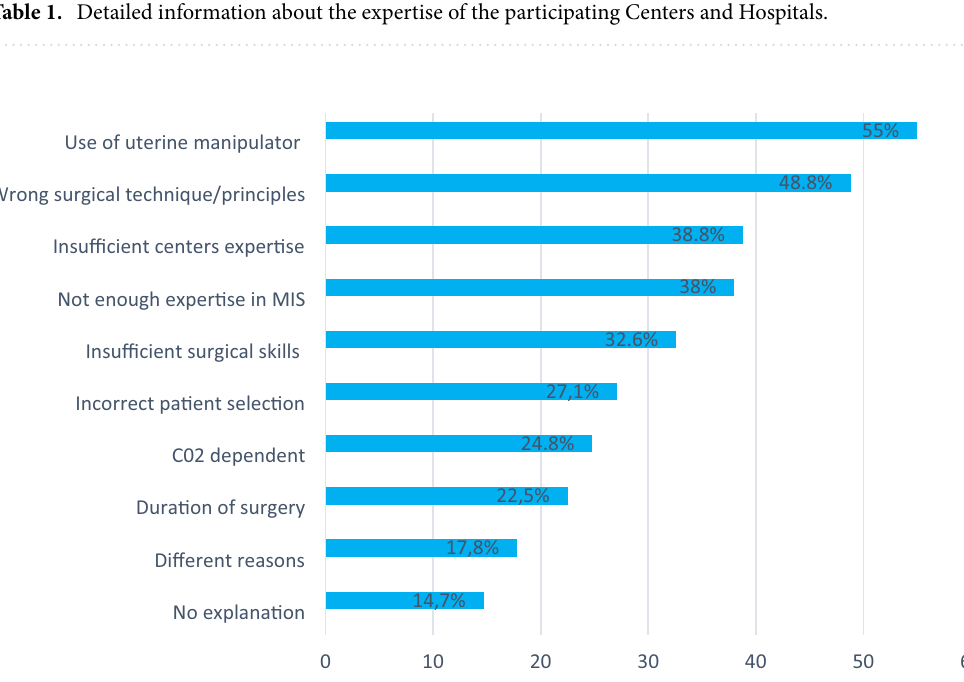
Figure 1. Reasons (according to given possible answers in the survey) for inferior outcome in the MIS